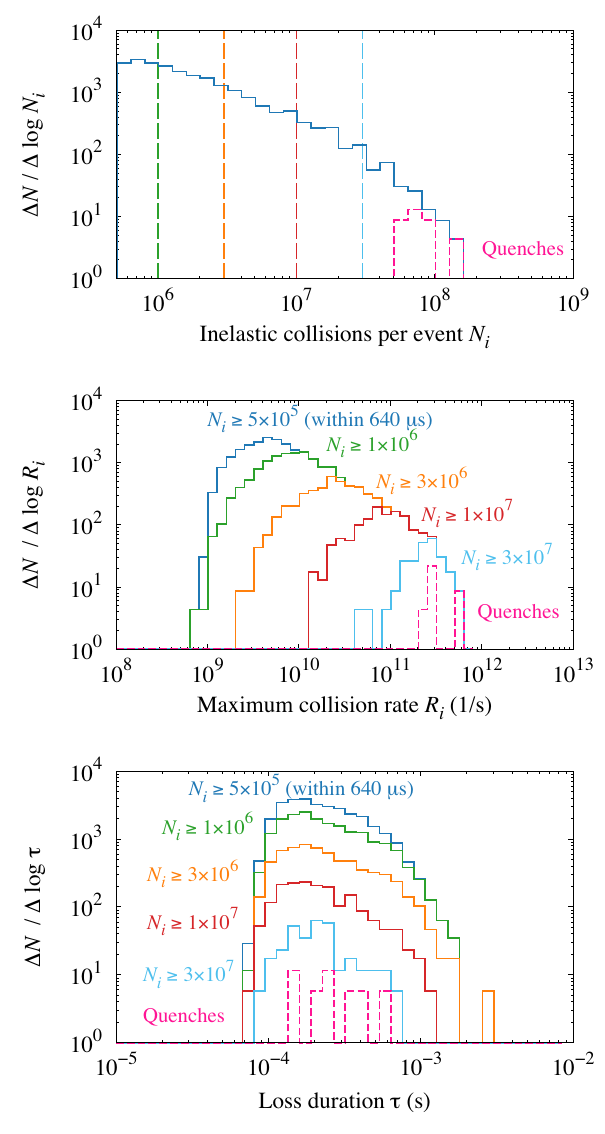
FIG. 8. Reconstructed experimental distributions of dust events as a function of collisions per event (top), maximum collision rate (center), and loss duration (bottom). The figure considers about N ¼ 5500 loss events, which were recorded in the LHC arcs during 6.5 TeV proton operation in run II. In addition, one dust- induced quench at 6.39 TeV and one quench in the dispersion suppressor are included (at 6.5 TeV). The two bottom figures show different subsets of events exceeding a minimum number of collisions indicated by the vertical lines in the top figure. Events leading to a quench are represented by the dashed